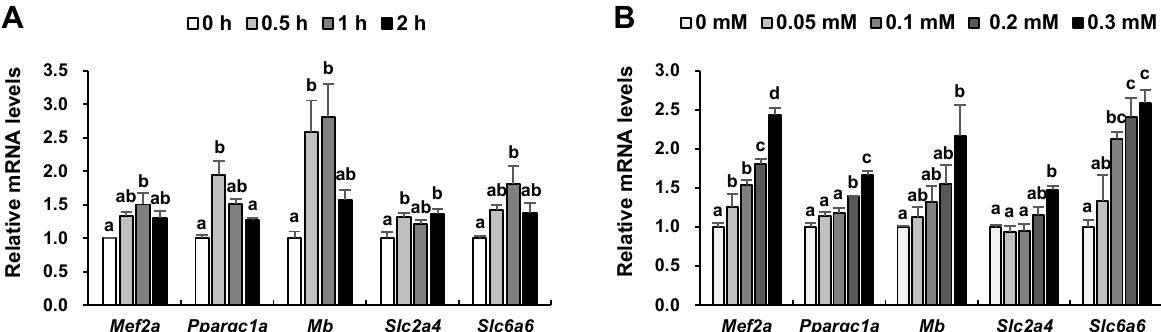
Figure 5. Effects of taurine on the expression levels of MEF2A, PGC-1 α , myoglobin, GLUT4, and TauT genes in L6 myotubes. ( A ) L6 myotubes were treated with 0.3 mM taurine for the time periods indicated. ( B ) L6 cells were treated with 0, 0.05, 0.1, 0.2, and 0.3 mM taurine for 1 h. Total RNA was extracted from the cells after treatment with taurine and qRT-PCR analysis was carried out to determine the mRNA expression levels of Mef2a , Ppargc1a , Mb , Slc2a4 , and Slc6a6 in L6 cells, as de- scribed in the Materials and Methods section. Values shown represent the mean ± SE (n = 3–6). Re- sults were analyzed using one-way analysis of variance (ANOVA) followed by Tukey’s test for mul- tiple comparisons. Values with different superscript lowercase letters indicate significant differ- ences ( p < 0.05).